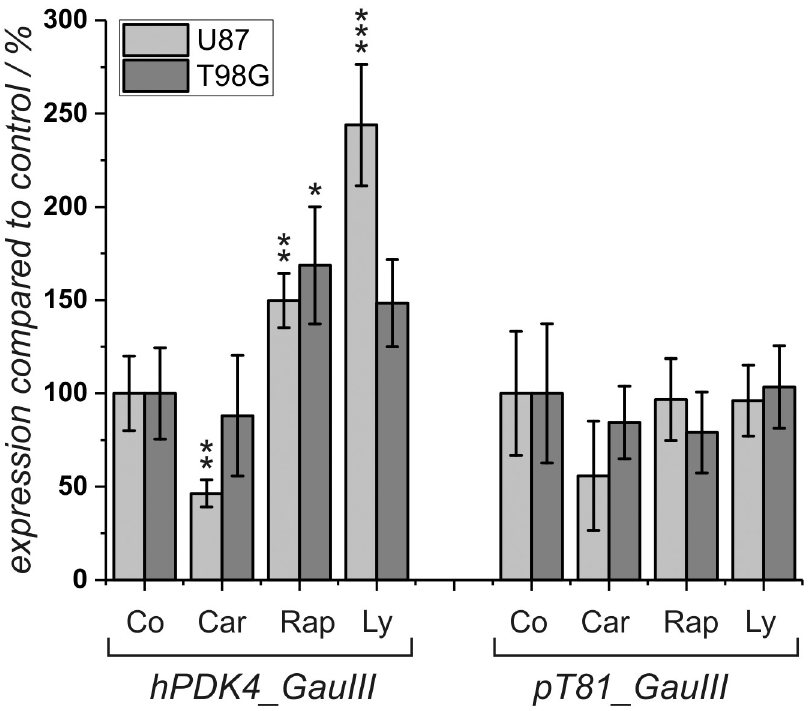
were transfected into U87 and T98G cells. Cells were exposed to carnosine (Car; 50 mM), rapamycin (Rap; 25 nM), Ly- 294,002 (Ly; 5 μ M) or to vehicle control (Con) and luciferase activity was determined after 24 hours of incubation (6 independent wells). � : p < 0.05; �� : p < 0.005, and ��� : p <